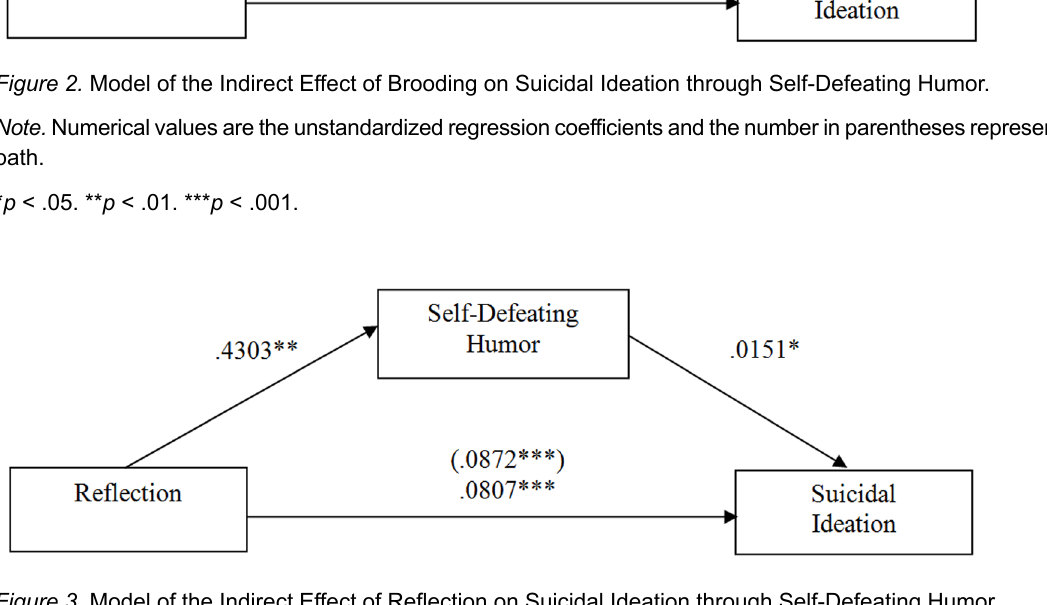
Figure 3. Model of the Indirect Effect of Reflection on Suicidal Ideation through Self-Defeating Humor. Note . Numerical values are the unstandardized regression coefficients and the number in parentheses represents the unmediated path. * p < .05. ** p < .01. *** p <